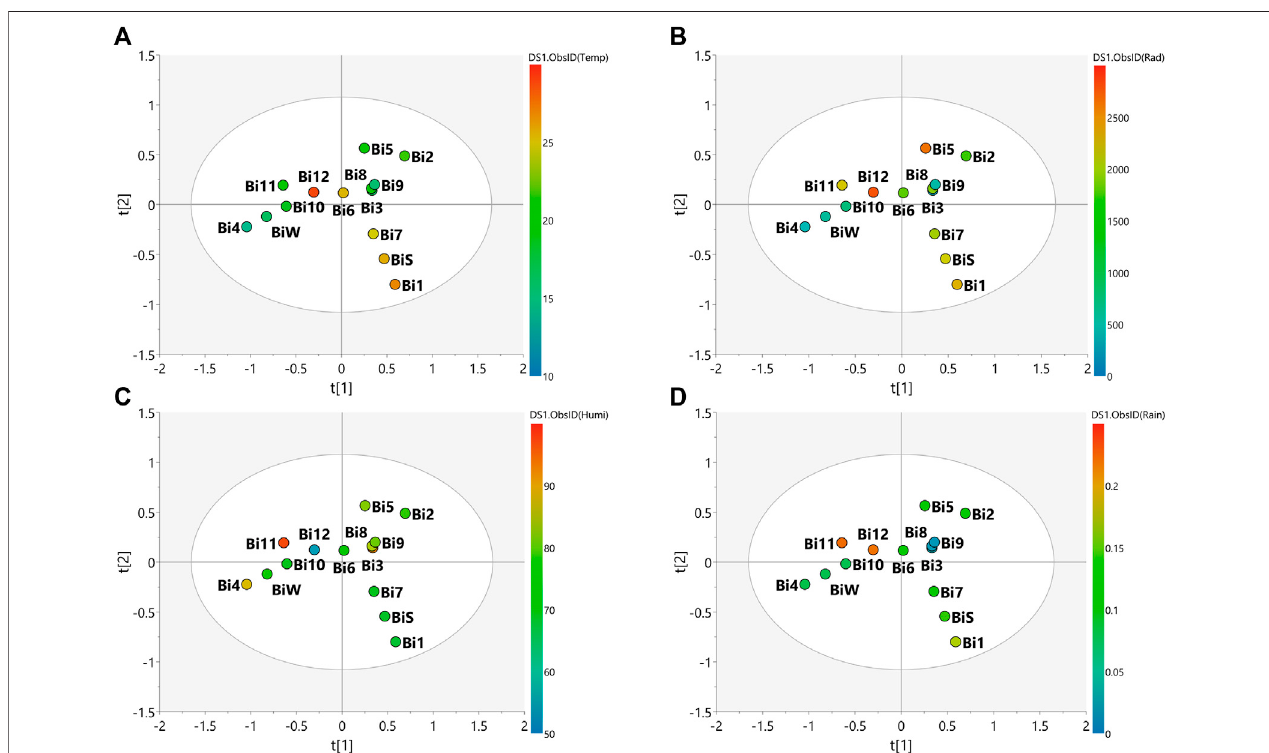
FIGURE3| PLS-DAscorescatter plotsoftheMS-NMRfused dataof B.intermedia seasonalharvests andthecorrelationwiththeenvironmental factors. Samples are categorized according to the values of observations for environmental factors. (A) Temp (cid:2) temperature ( ° C); (B) Rad (cid:2) Solar radiation (kJ/m 2 ); (C) Humi: relative humidity (%) and (D) Rain (cid:2) rainfall (mm). Sample seasons: Summer (Bi1, Bi7 and BiS); Autumn (Bi2, Bi3, Bi8 and Bi9); Winter (Bi4, Bi10 and BiW) and Spring (Bi5, Bi6, Bi11 and